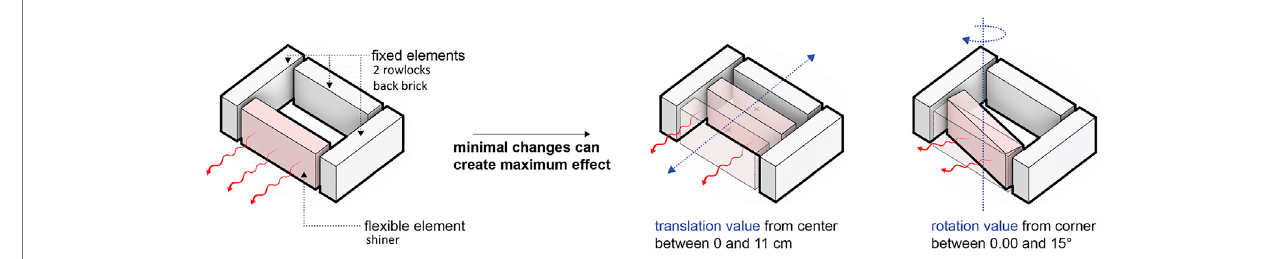
FIGURE 4 | While the side headers, the rowlocks and the back brick of the rat-trap bonded brickwork remain fi xed, two parameters of the front brick, shiner — rotation and translation — can be modulated to create a self-shading effect and thus reduce the exposure of the entire surface to solar radiation.